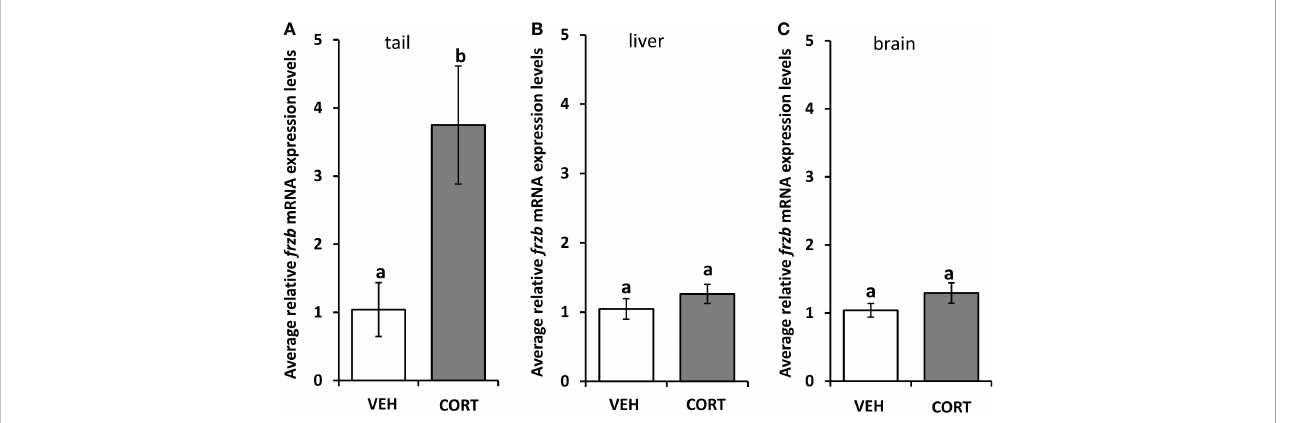
FIGURE 3 Tissue expression pro fi le of frzb in tadpoles. Premetamorphic tadpoles (NF 54) were treated with vehicle and 100 nM CORT (corticosterone) for 24 hours. Tails (A) , livers (B) , and brains (C) were dissected, followed by RNA extraction and quantitative PCR to measure mRNA expression of frzb and the housekeeping gene rpl8. Bars represent mean mRNA levels relative to rpl8 and normalized to a vehicle control sample. n = 10 tail samples per treatment. Error bars represent SE. Letters indicate signi fi cant groups, p <